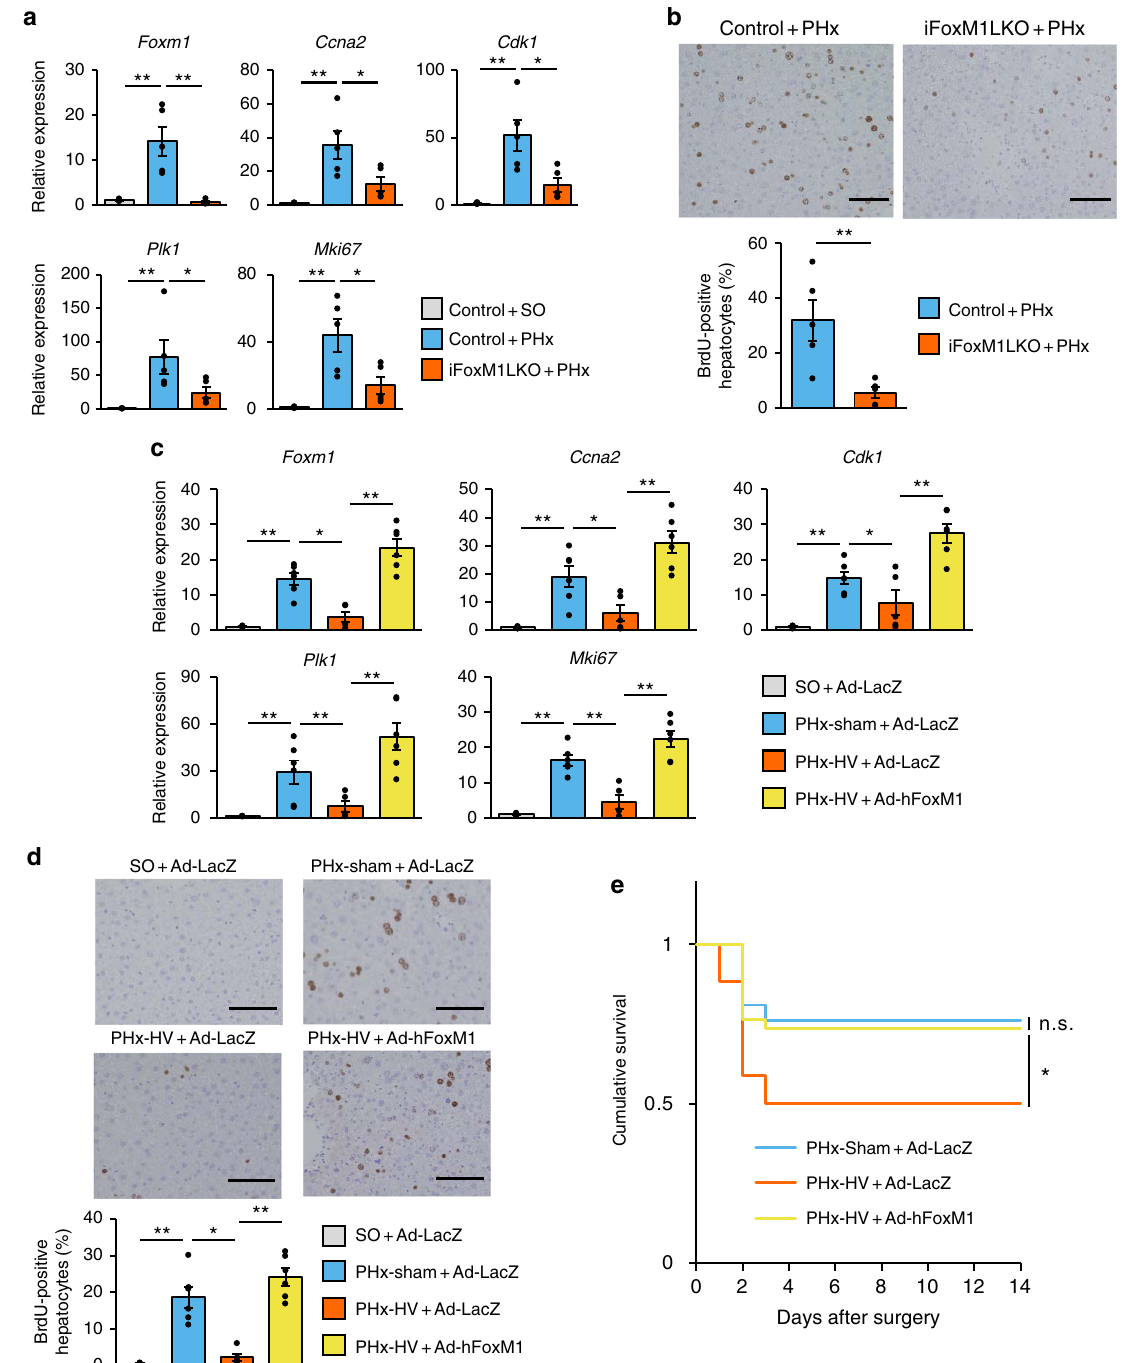
Fig. 3 FoxM1 activation promotes liver regeneration and whole-body survival. a Relative expressions of Foxm1 , its target genes, and MKi67 in the liver 2 days after surgery in control mice that underwent SO ( n = 5) and PHx ( n = 5), and iFoxM1LKO mice that underwent PHx ( n = 5). b (Upper panels) Representative images of liver sections immunostained for BrdU 2 days after PHx from control and iFoxM1LKO mice. Scale bars indicate 100 µ m. (Lower panel) BrdU-positive hepatocyte ratios in control ( n = 5) and iFoxM1LKO ( n = 5) mice 2 days after PHx. c Relative expressions of Foxm1 , its target genes, and MKi67 in the liver 2 days after SO ( n = 5), PHx-sham ( n = 6), and PHx-HV ( n = 5) in mice receiving Ad-LacZ and after PHx-HV in mice receiving Ad-hFoxM1 ( n = 6). d (Upper panels) Representative images of liver sections immunostained for BrdU 2 days after SO, PHx-sham, and PHx-HV from mice receiving Ad-LacZ and after PHx-HV from mice receiving Ad-hFoxM1. Scale bars indicate 100 µ m. (Lower panel) BrdU-positive hepatocyte ratios in the liver 2 days after SO ( n = 5), PHx-sham ( n = 6), and PHx-HV ( n = 5) in Ad-LacZ-treated mice and PHx-HV in Ad-hFoxM1-treated mice (n =